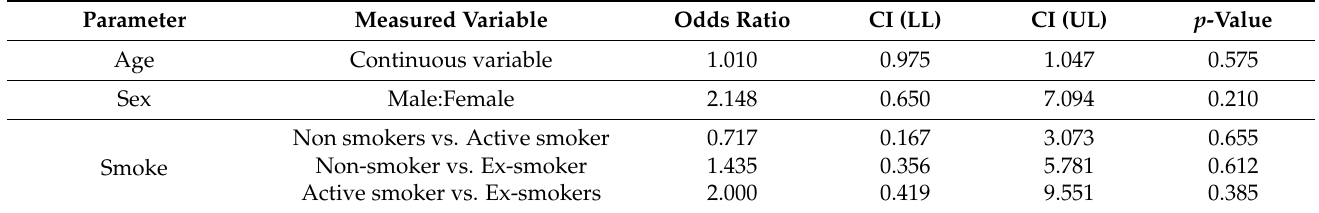
Table 2. Univariate analysis results. CI (LL) = Confidence Interval (Lower Limit); CI (UL) = Confi- dence Interval (Upper Limit); BMI = Body Mass Index; ASA = American Society of Anesthesiolo- gists.